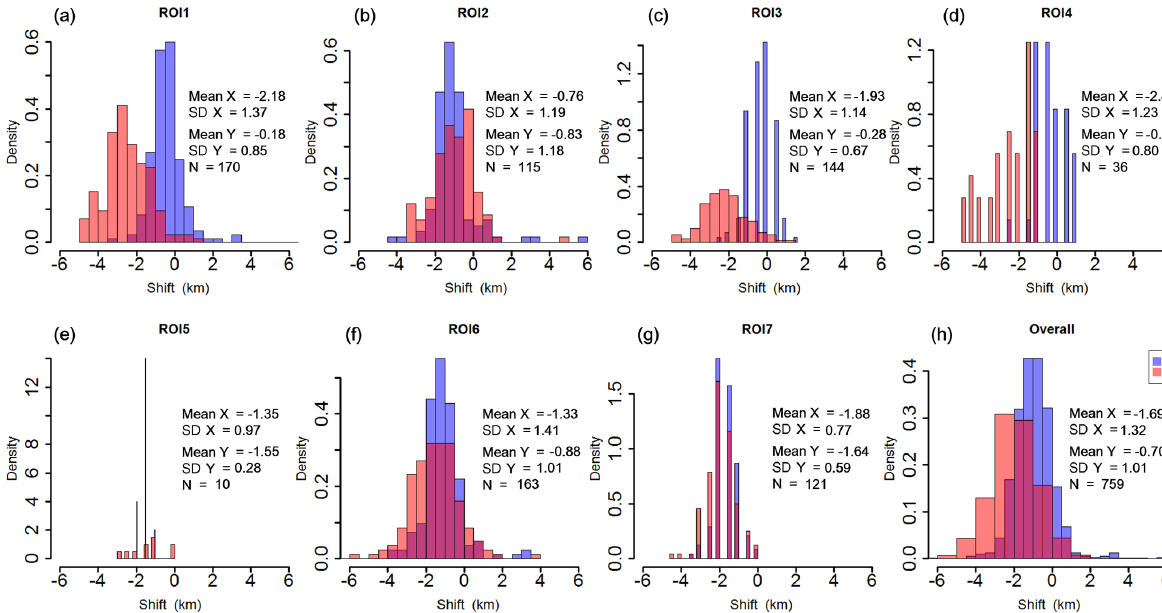
Figure 5. The distribution of shifts in the across-track ( x , represented by the red histogram) and along-track ( y , denoted as the blue histogram) directions over different regions for the NOAA-17 scene. The unit of the shift is kilometers. For histograms, the heights of the bars indicate the density. In this case, the area of each bar is the relative frequency, and the total area of the histogram is equal to 1. Table 2. Summary of the results for the scene of NOAA-17. The unit of the shift is kilometers. ROI